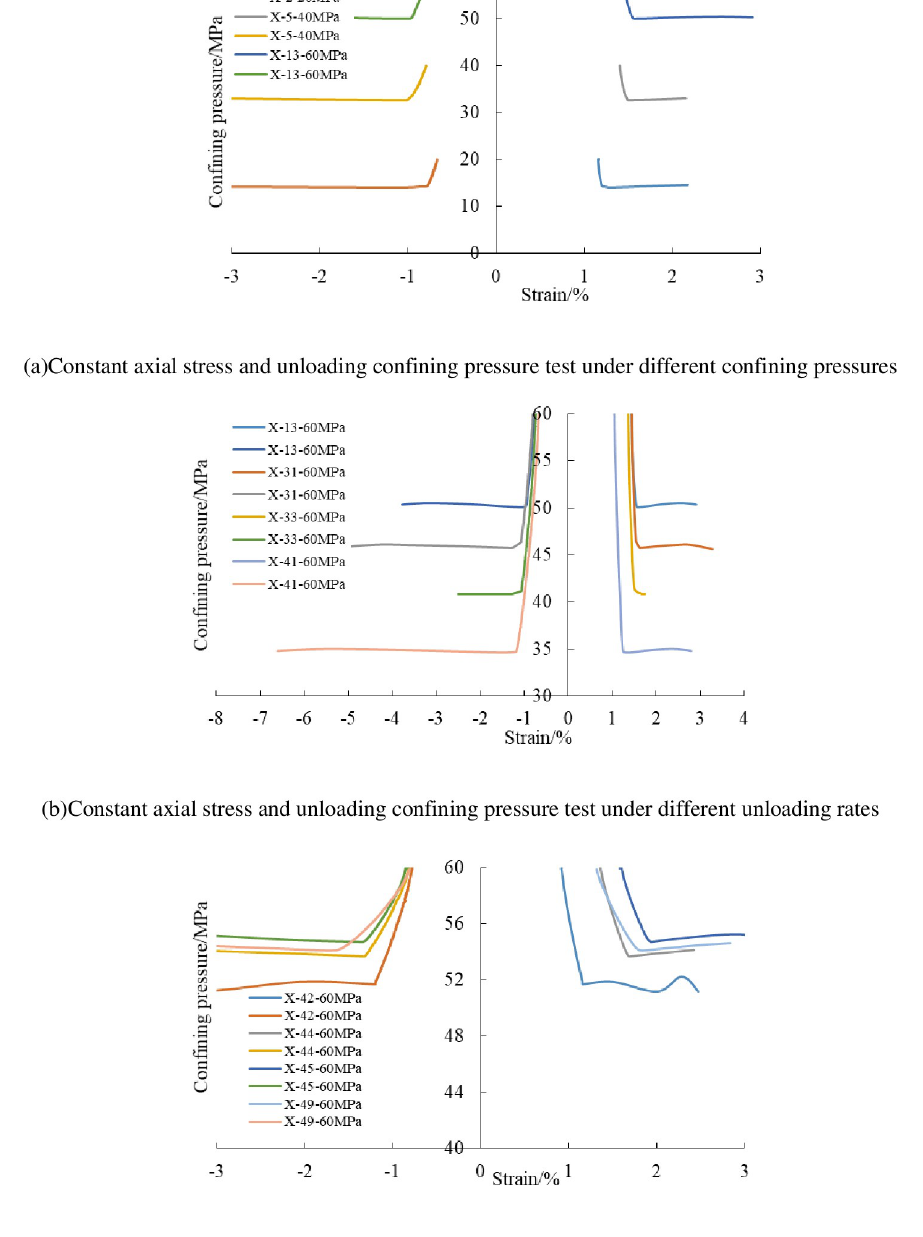
Fig 4. The relationship between confining pressure and strains of shale specimens under unloading